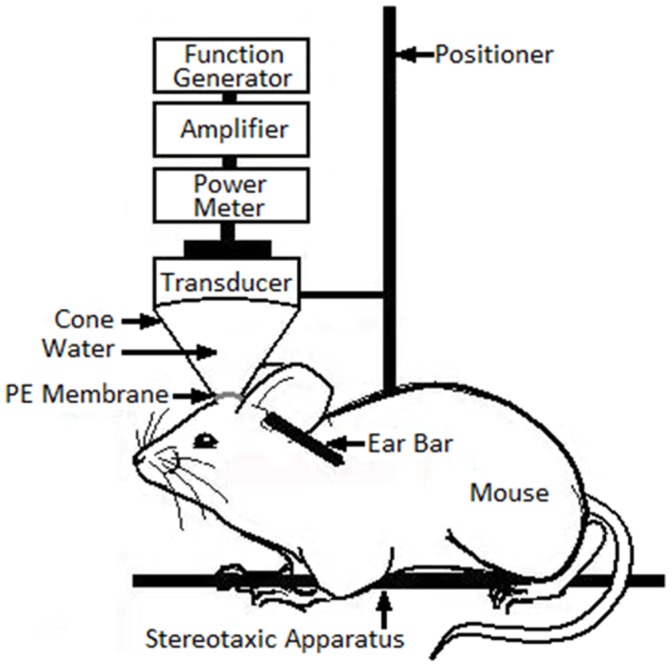
Schematic diagram of the experimental setup for blood-brain barrier opening.The positioner was also mounted on a stereotaxic apparatus. PE, polyurethane.